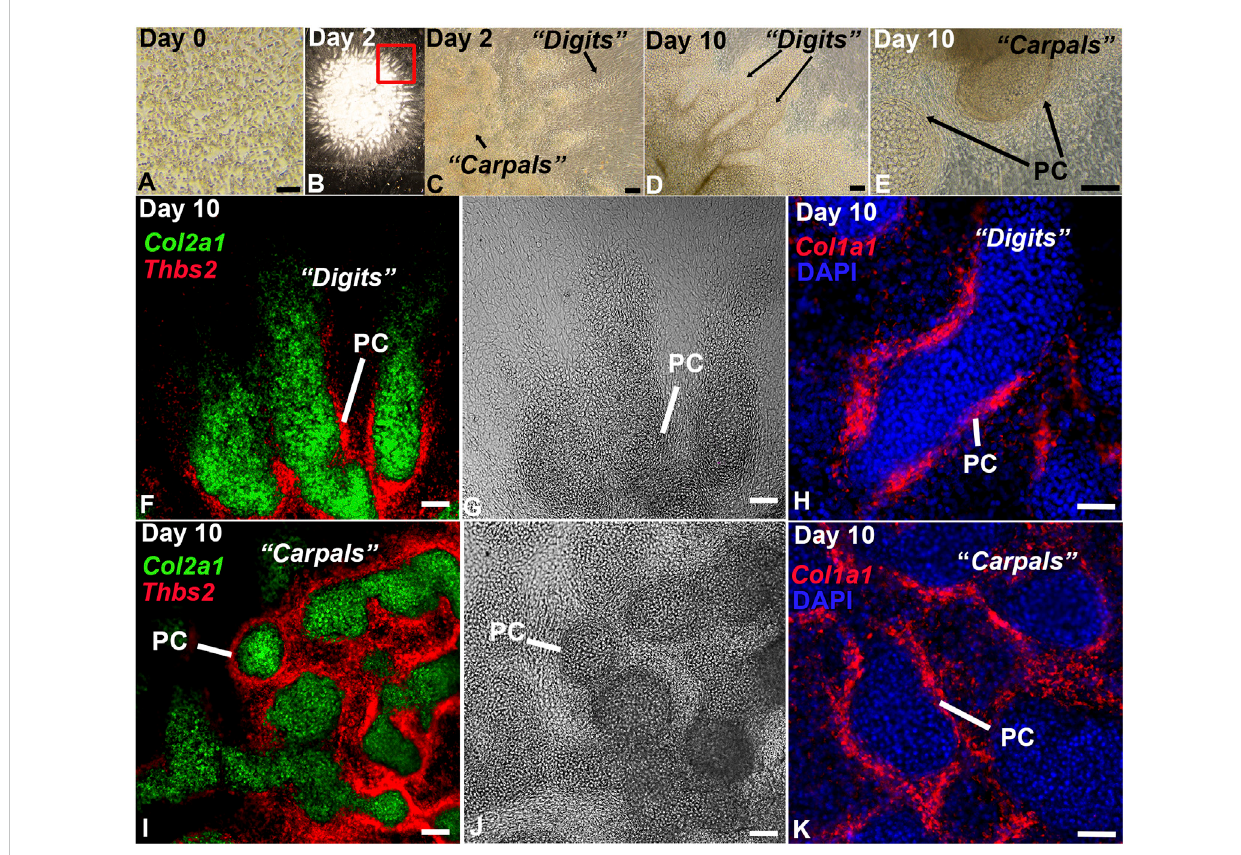
FIGURE 2 In vitro culture of distal limb mesenchyme recapitulates digit and carpal element formation. (A) Bright fi eld image of the disassociated E11.5 distal forelimb mesenchyme atDay 0. (B) Low magni fi cation imageof an entire DID culture at Day 2 showing re-assembly and development of the dissociated mesenchyme into digit-like projections. (C) Higher magni fi cation image of the boxed region in panel (B) . Arrows denote digit- and carpal-like elements. (D,E) AnalysisofDay10DIDculturesrevealedwell-formeddigitsandcarpalelementsproducingavisibleperichondrium(PC). (F – K) HCRRNA-FISH analysis of gene expression in Day 2 DIDs reveal robust expression of Col2a1 in the central condensations and Col1a1 and Thbs2 localizing to the tissue surrounding these structures, consistent with the formation of a perichondrium (PC). Bars = 50